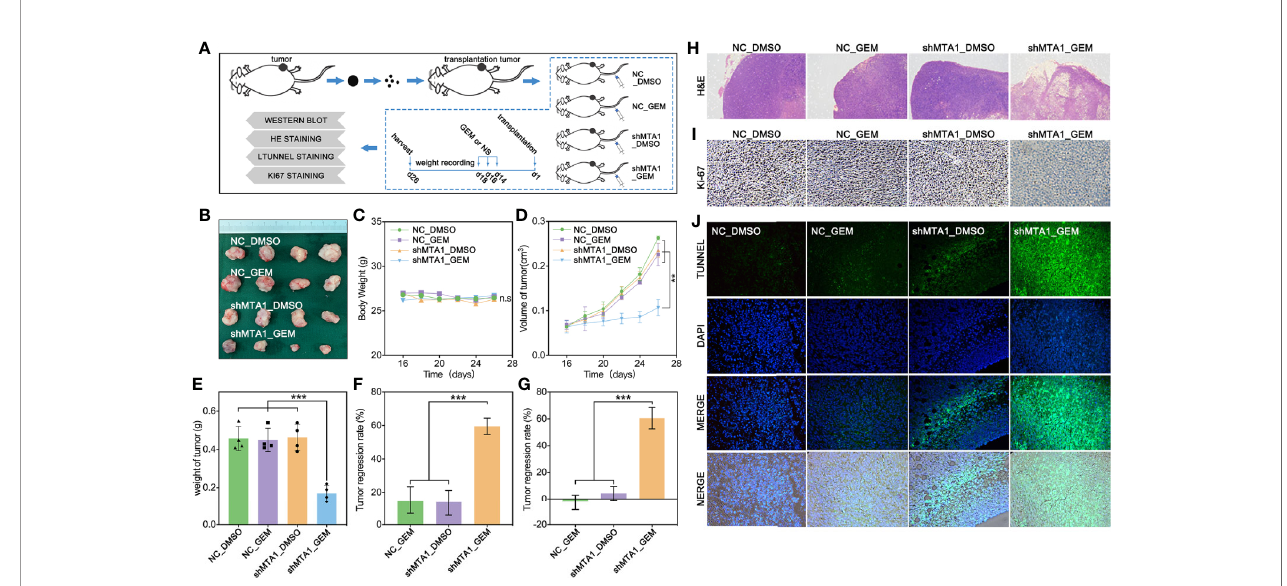
FIGURE 4 | MTA1 knockdown enhanced gemcitabine mediated tumor growth restriction effect in vivo . (1) Experiments processed in vivo (A) . (2) Volume of subcutaneous transplantation tumor (B) . (3) Weight of mouse (C) . (4) Volume of tumors in vivo (D) . (5) Weight of tumors (E) . (6) Calculation of tumor growth inhibition by volume (F) and weight (G) , respectively. (7) H&E staining (H) , ki-67 staining (I) and tunnel assay, in which the green area means death (J) .